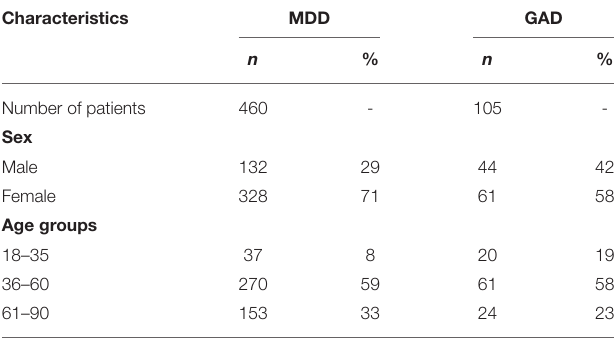
TABLE 1 | Characteristics of patients who completed 8 weeks of